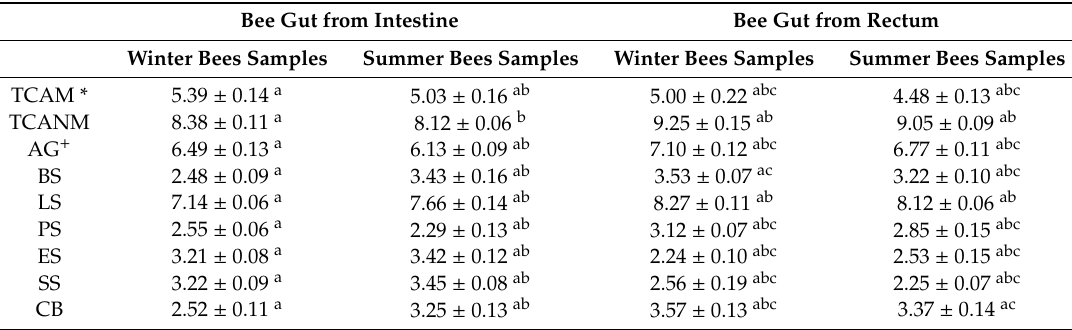
Table 1. Isolated bacteriota of adult worker honeybee guts in in log cfu / g (mean ± SD). Bee Gut from Intestine